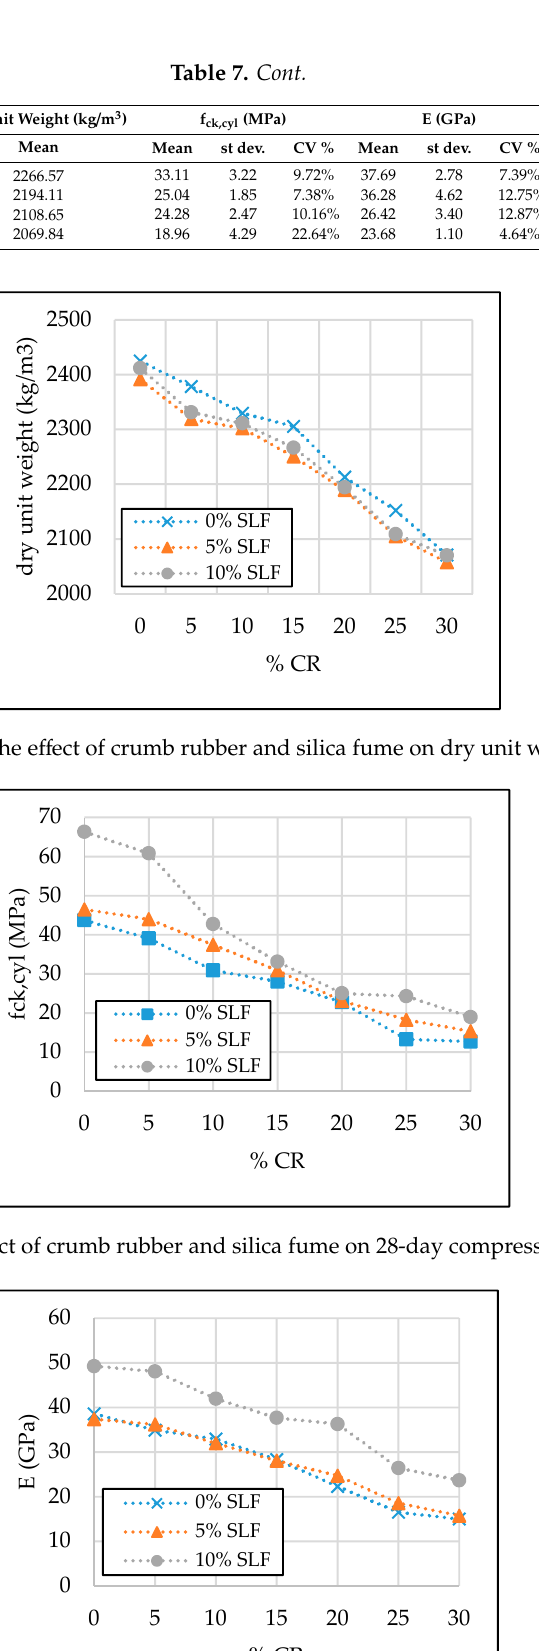
Figure 14. The effect of crumb rubber and silica fume on 28-day flexural strength. 3.2.1. Dry Unit Weight The unit weight of SCC cylinders and prisms was measured after 28 days. The results given in Table 7 and Figure 11 show that the dry unit weight decreases with an increasing content of crumb rubber due to its low specific gravity (1.05 g/cm 3 ). The relative decrease in dry unit weight was approximately 7% and 15% with 15% and 30% replacement levels of fine aggregate and 0% and 5% replacement levels of cement, respectively. An almost linear relationship between a reduction in dry unit weight and increase of replacement level of natural fine aggregate with crumb rubber was observed. Lightweight self-compacting concrete with a dry unit weight around 2069 kg/m 3 was obtained, with 30% of the fine aggregate replacement level, which ultimately leads to a lower total mass of the concrete structures if such concrete is intended for structural purposes. 3.2.2. Compressive Strength (f ck, cyl ) As expected, the mean value of three measurements of 28-day compressive strength was the lowest, i.e., 12.21 MPa, when the CR and SLF replacement levels were 30% and 0%, respectively. The negative impact of CR on the 28-day compressive strength can be described with a poor rubber granule–cement paste bond and with a low rubber modulus of elasticity compared to natural aggregates [5,62]. On the contrary, the mean value of three measurements of 28-day compressive strength was the greatest when the replacement level of cement with silica fume was 10%, with 0% of crumb rubber content, i.e., 66.30 MPa (Table 7, Figure 12). As a result of its pozzolanic activity, silica fume contributes to the increase in values of not only its compressive strength, but also the